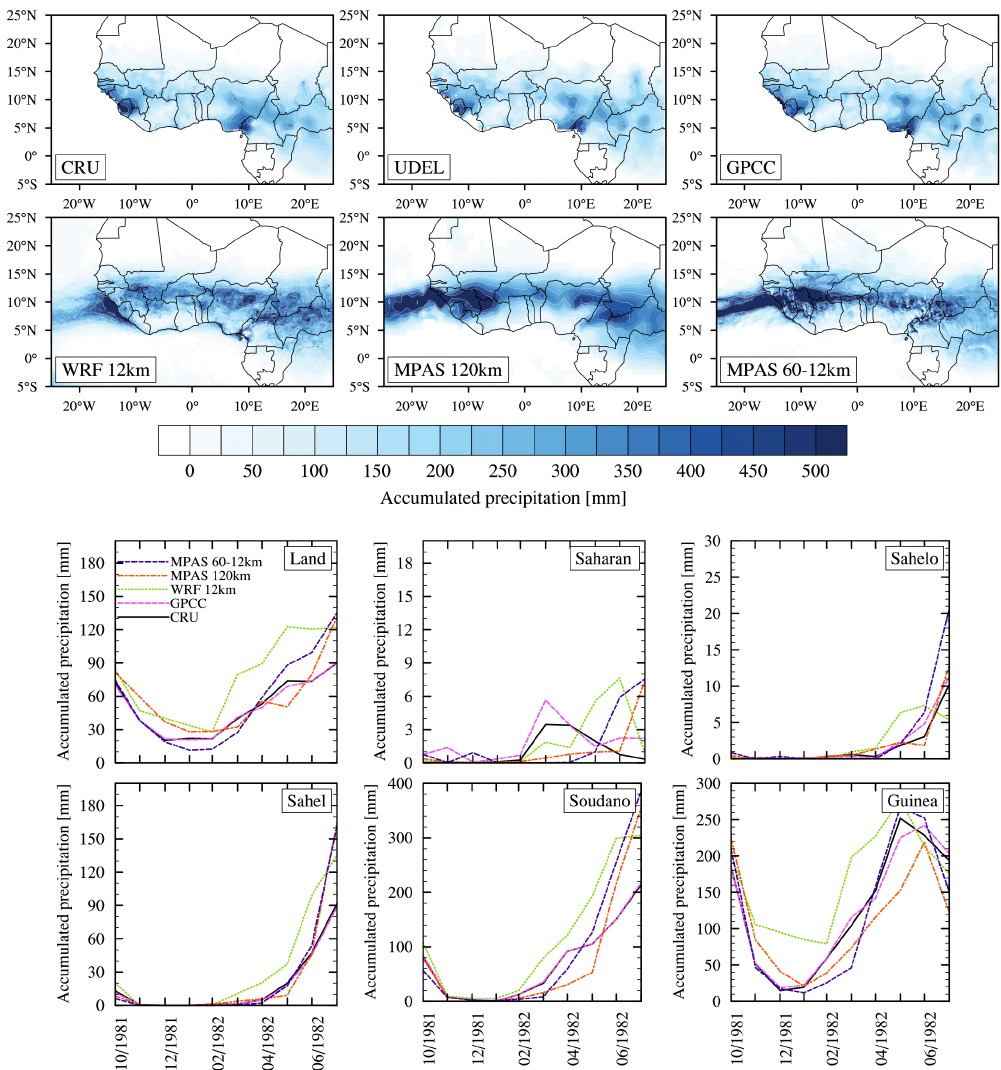
Figure 10. (Top) monthly precipitation (over land) in millimetres for July 1982 for the three observational data sets CRU, UDEL, GPCC, the WRF reference and the two MPAS model runs; (bottom) annual cycle of monthly precipitation over the entire land area and the five agro-climatical zones depicted in Fig.